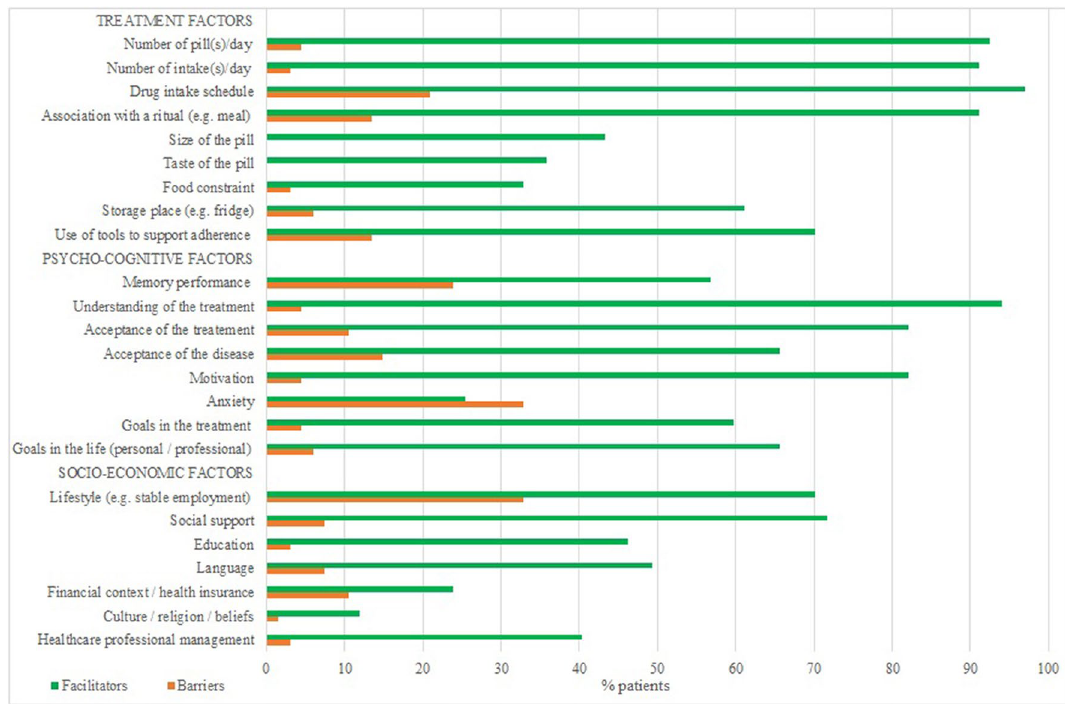
Figure 4. Facilitators of and barriers to fingolimod adherence by F-PSP